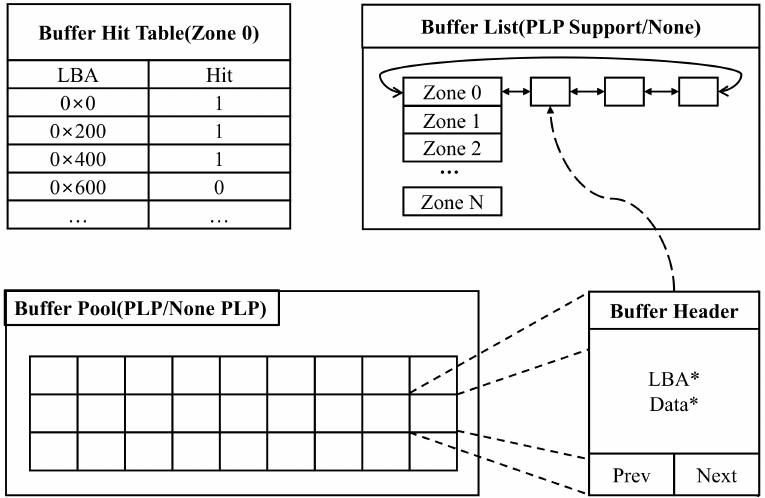
Figure 6. Buffer hit table and Buffer list for managing PLP and Non-PLP